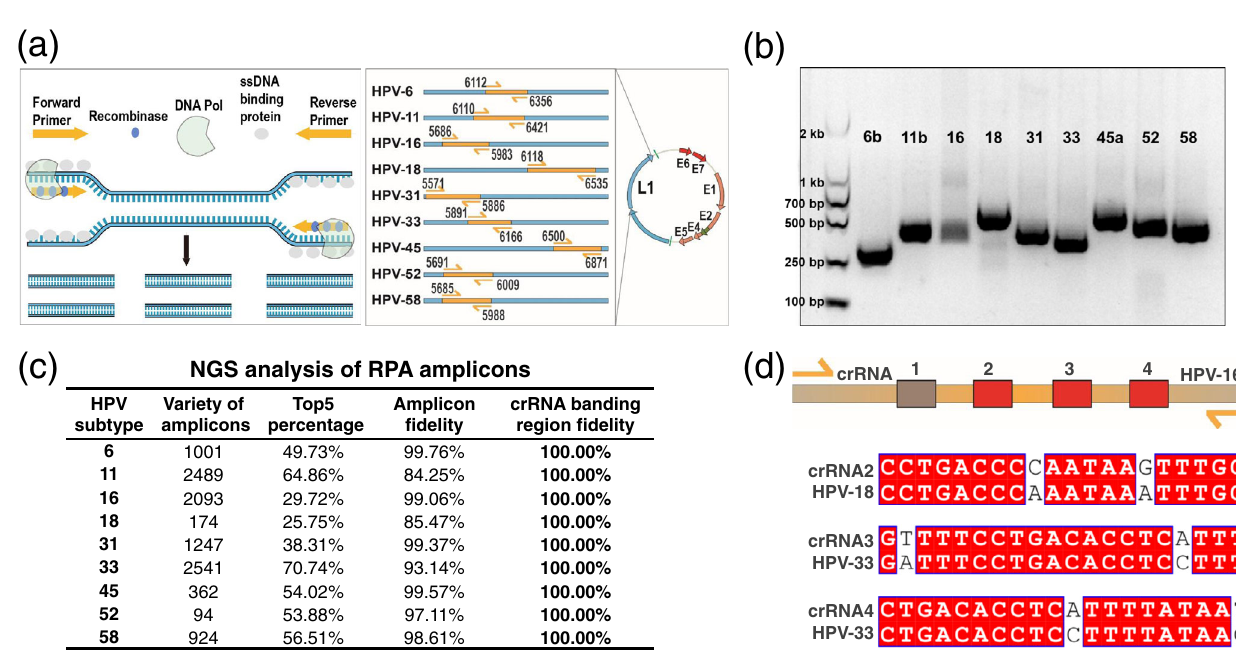
Fig.2|DesigningofRPAprimersandcrRNAs.a RPAprimerdesigningforthenine HPV subtypes. b Agarose gel results showing the RPA products of the nine targets afterampli fi cationwithoptimalprimers.Theexperimentwasrepeatedatleasttwo